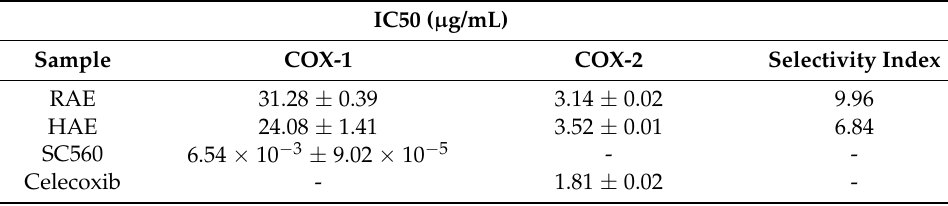
Table 7. IC50 and selectivity indices of MS extracts on COX enzymes.